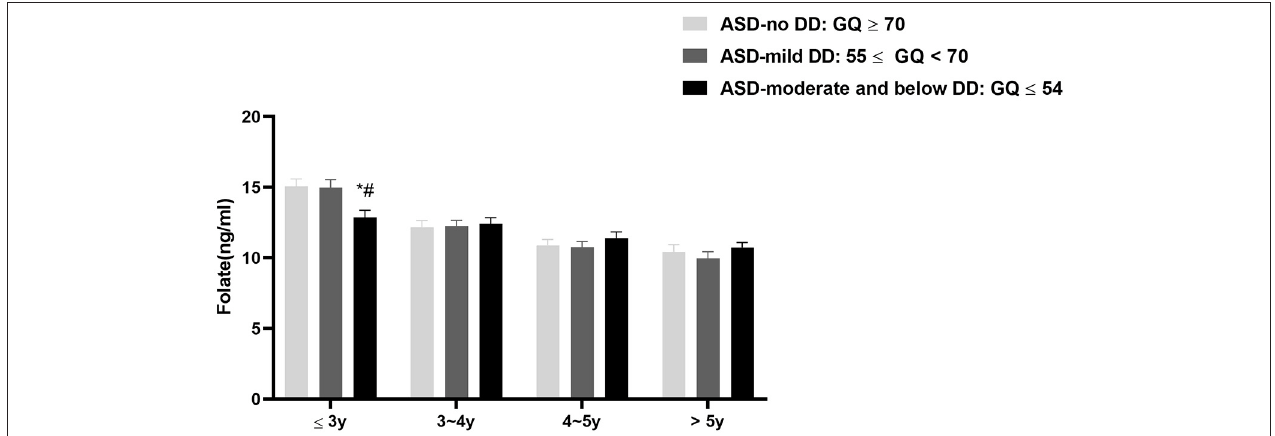
FIGURE 3 | The serum folate levels among autistic children with different neurodevelopmental levels; Data was presented as mean ± SEM. The Kruskal-Wallis test was used for the comparison. * P < 0.05 vs. the ASD-no DD group, # P < 0.05 vs. the ASD-mild DD